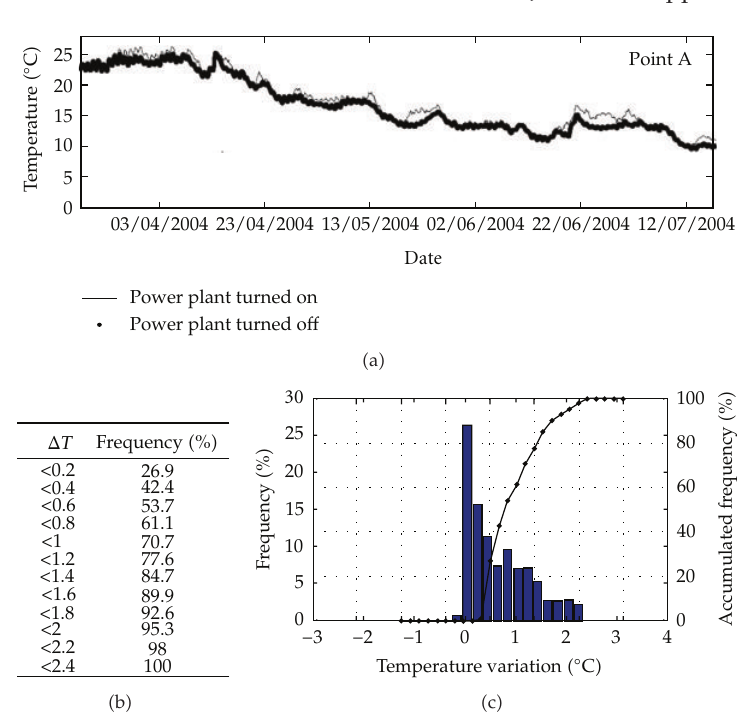
Figure 16: Time evolution of the water temperature calculated with the model in the income power plant (cid:3) point A (cid:4) with the power plant turned on and turned o ff . Histogram of the Δ T in point A. respectively. It is noticeable that there is a greater impact on the water temperature in the port area represented by the point J than in the outside area represented by the point